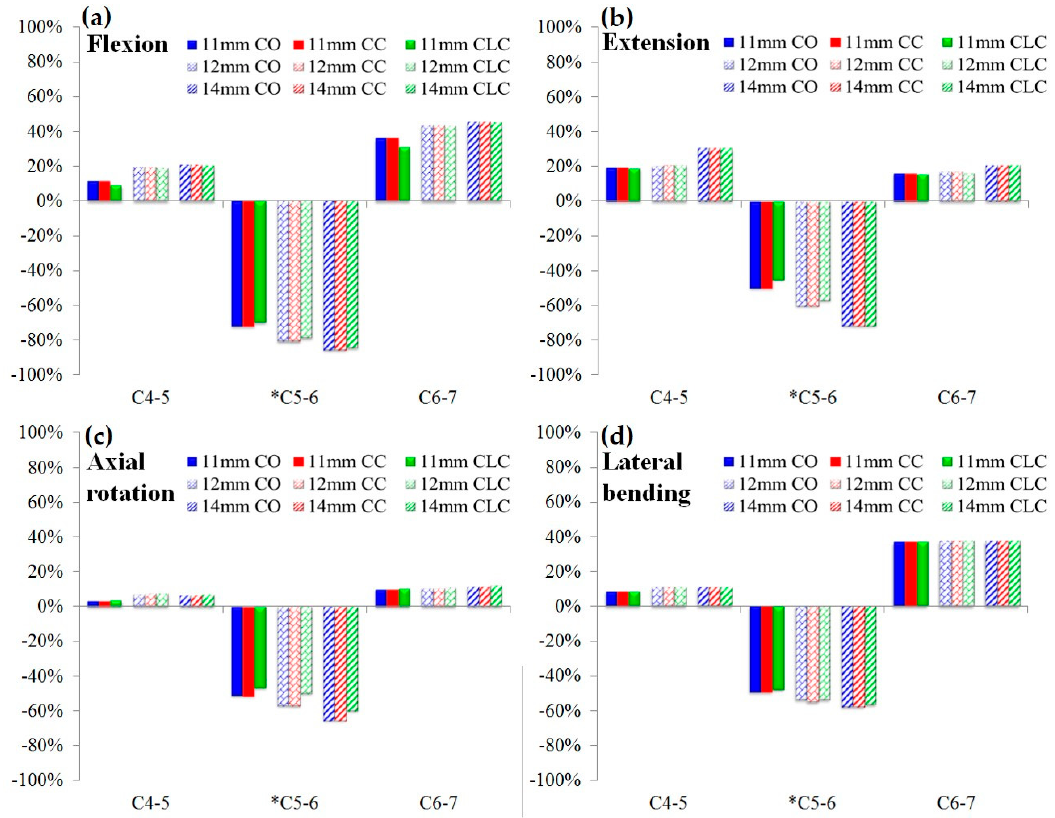
Figure 3. Effects of different cervical allograft spacers on the range of motion, compared with that in an intact model: ( a ) flexion ( b ) extension ( c ) axial rotation ( d ) lateral bending. * indicates fused cervical segment with allograft spacers. CO, cortical only; CC, cortico-cancellous; CLC, cortical lateral walls with a cancellous center bone.